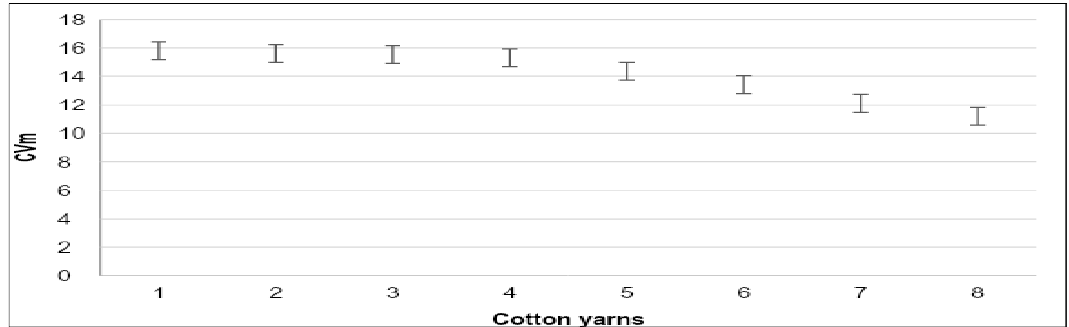
Fig. 4: Twist and coefficient of mass variation (CVm) of the yarns